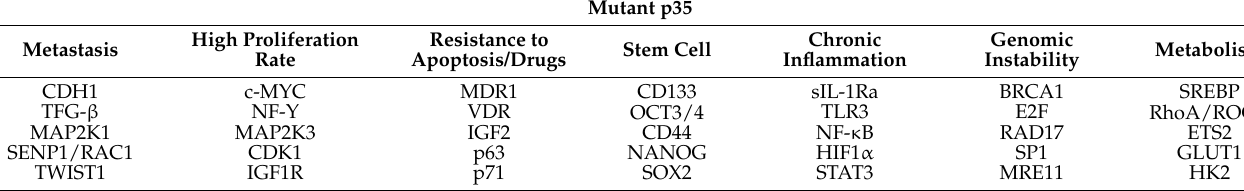
Figure 4. Schematic representation of the effects of mutp53 on cancer-stem-cell–related genes and chemoresistance function. Mutp53 induces EZH2 to block the function of differentiation genes and triggers YAP/TAZ signaling to upregulate stemness genes, which are induced to chemoresistance-related genes. Mutp53 also induces the cancer stem cell related genes, such as CD44, LGR5, CD133, and EpCAM, which might induce the metastasis and cancer progression. Table 5. Models of the multifunctionality of mutant p53. Mut-p53 induces various biological functions, such as chronic inflammation, deregulation of cellular metabolism, high proliferation rate, genomic instability, metastasis, resistance to apoptosis/therapeutic drugs, and stem cells. The figure is adapted and modified to show the various biological functions induced by mutp53 [38].